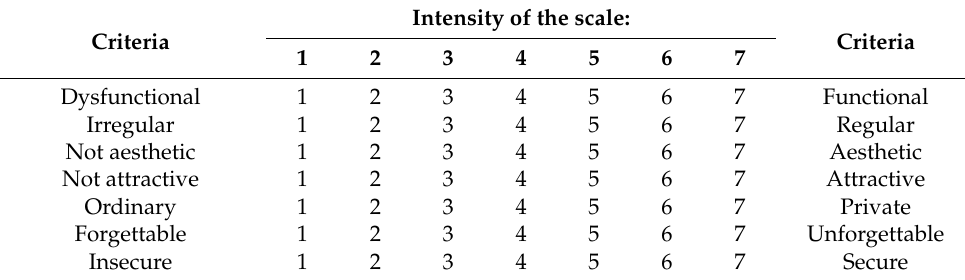
Table 1. Evaluation system of the criteria used in the survey.